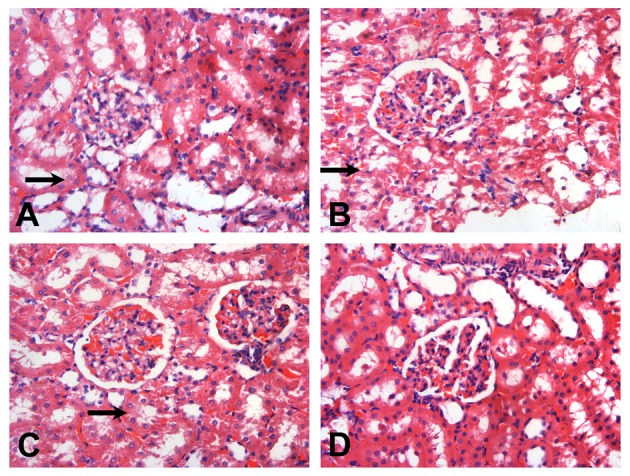
Representative sections of the glomeruli of SD rats on the day 14 (HE, × 200). After RSV reinfection, the renal tubules were shown with different extents of vacuolar degeneration (). The renal interstitium was swollen. The changes in Groups B3 (B) and C3 (C) were more serious than that in Group A3 (A). There were hardly obvious changes on the renal tubules in Group D3 (D). No obvious changes were observed in the glomeruli under light microscopy. (A) The 6 × 104 PFU, RSV + vehicle, day 14 subgroup (Group A3); (B) The 6 × 104 PFU RSV + 6 × 106 PFU RSV, day 14 subgroup (Group B3); (C) The 6 × 104 PFU RSV + 6 × 104 PFU RSV, day 14 subgroup (Group C3); (D) Vehicle + vehicle group, day 14 subgroup (Group D3).